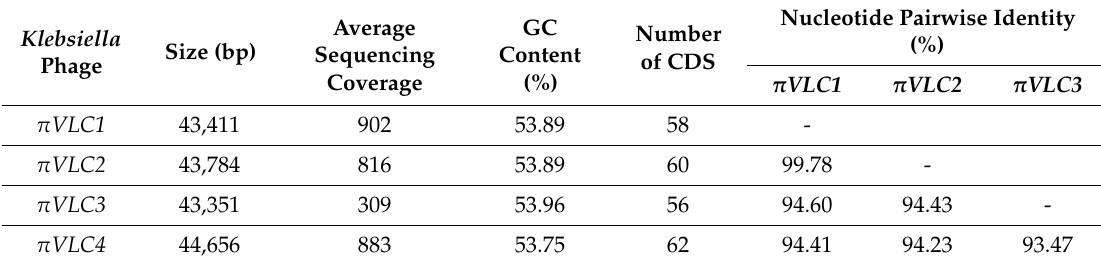
Table 2. De novo assembly of the novel K. pneumoniae phage genomes.